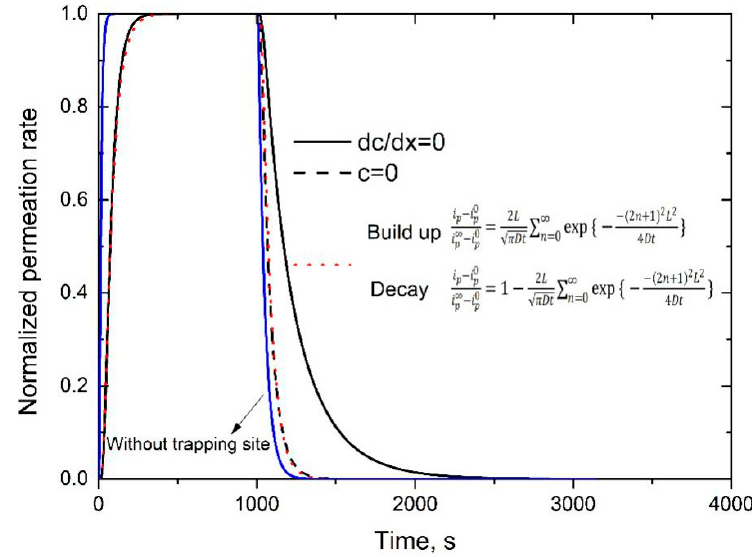
Figure 3. Simulated permeation curves with different boundary conditions at the initial entry side within the decay process. In this simulation, binding energy of 27 kJ/mol and trapping site density of 4.89 × 10 25 m − 3 were assumed. Hydrogen charging concentration at the entry side was assumed to be 1.0 ppm. After achieving steady state, hydrogen charging was turned off at 1000 s.